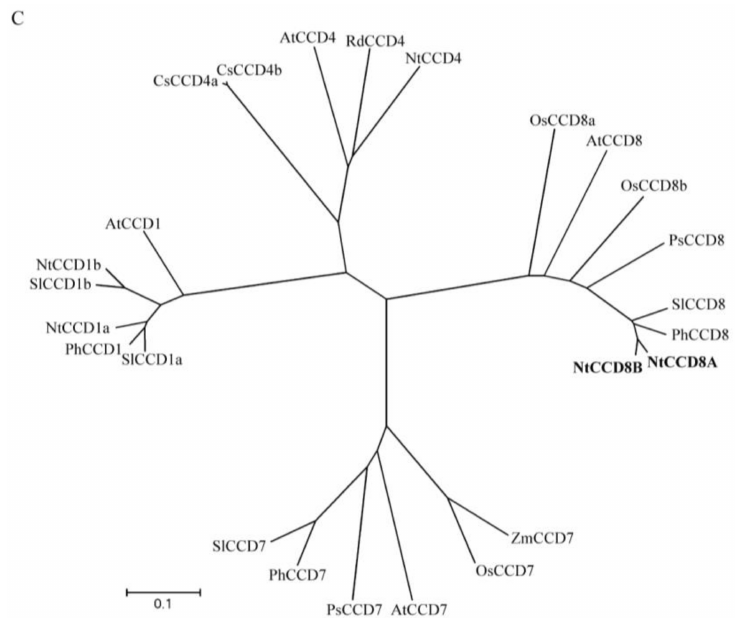
Figure 1. Characterization of NtCCD8 genes in tobacco ( Nicotiana tabacum ). ( A ) Putative exon/intron structure of the NtCCD8A and NtCCD8B genes. ( B ) Alignment of the putative NtCCD8A and NtCCD8B amino acid sequences with known CCD8 proteins from other plant species. Nt, Nicotiana tabacum ; At, Arabidopsis thaliana . Ph, Petunia hybrida ; Sl, Solanum lycopersicum . ( C ) Phylogenetic tree obtained for known CCD1, CCD4, CCD7 and CCD8 amino acid sequences; Nt, Nicotiana tabacum ; At, Arabidopsis thaliana ; Ph, Petunia hybrida ; Sl, Solanum lycopersicum . Os, Oryza sativa ; Ps, Pisum sativum ; Zm, Zea mays ; Cs, Crocus sativus ; Rd, Rosa damascena . Accession numbers for the sequences used